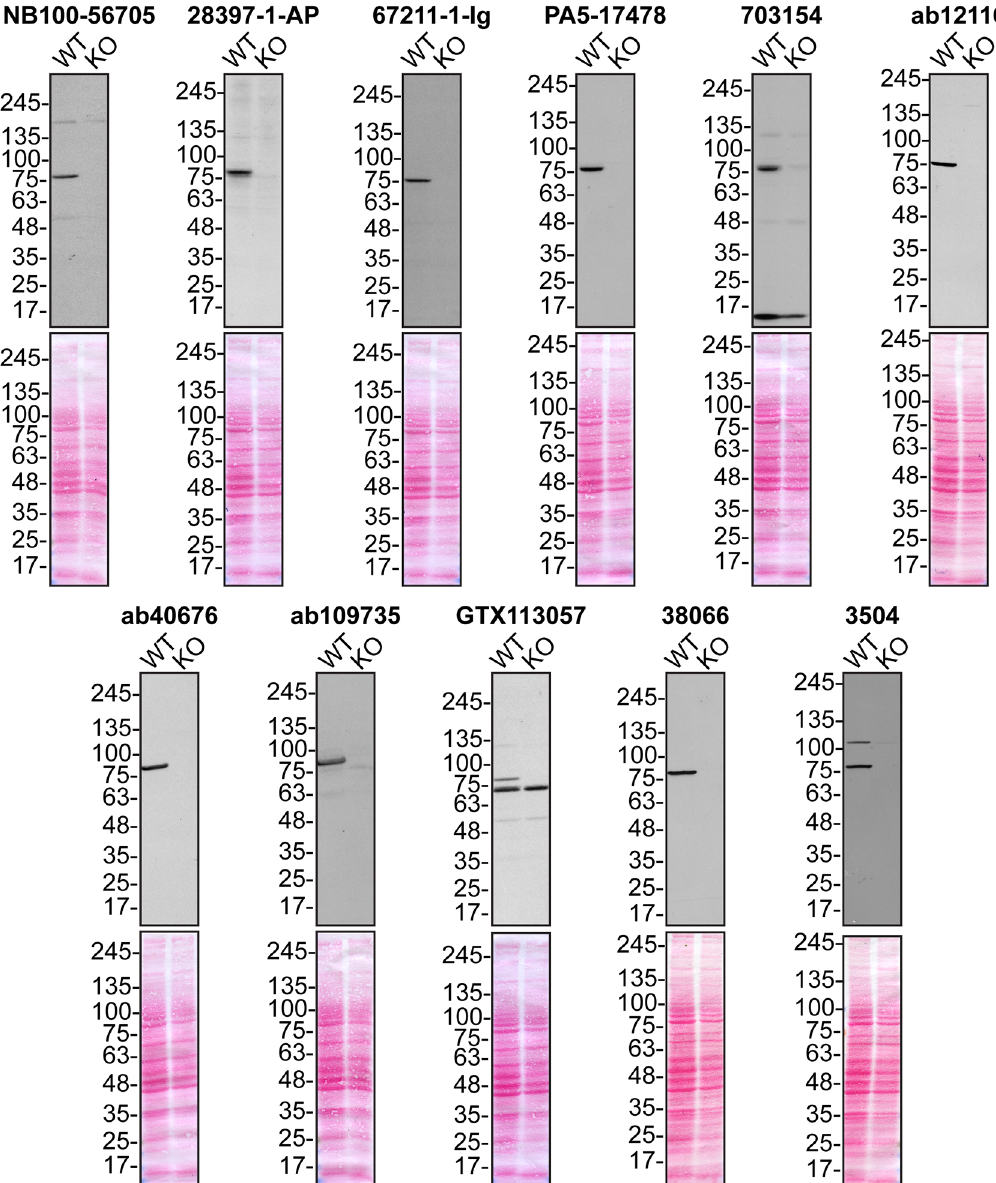
Figure 1. Serine/threonine-protein kinase TBK1 antibody screening by immunoblot. Lysates of U2OS (WT and TBK1 KO) were prepared and 50 μ g of protein were processed for immunoblot with the indicated TBK1 antibodies. The Ponceau stained transfers of each blot are presented to show equal loading of WT and KO lysates and proteintransferefficiencyfromtheacrylamidegelstothenitrocellulosemembrane.Antibodydilutionswerechosen according to the recommendations of the antibody supplier, except for antibodies 28397-1-AP, PA5-17478, 703154, ab40676, and ab109735, which were titrated at 1/10000 because the signal was too strong following the supplier ’ s recommendations.Antibodydilutionused:NB100-56705at1/500;28397-1-APat1/10000;67211-1-Igat1/1000;PA5- 17478 at 1/10000; 703154 at 1/10000; ab12116 at 1/600; ab40676 at 1/10000; ab109735 at 1/10000; GTX113057 at 1/ 2000, 38066 at 1/1000, 3504 at 1/1000. Predicted band size: ~83